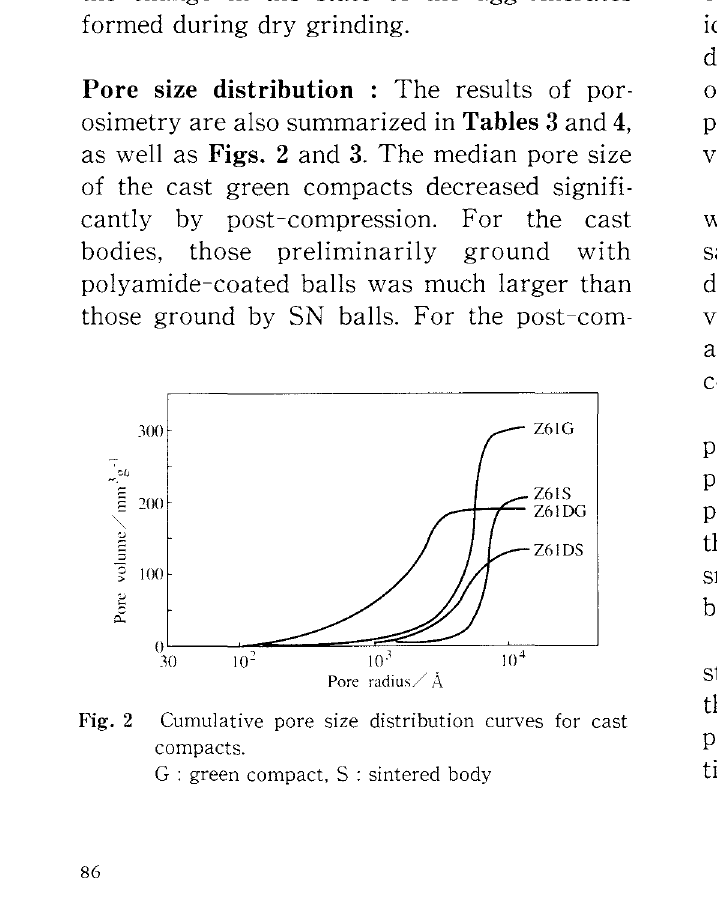
Cumulative pore size distribution curves for cast compacts.